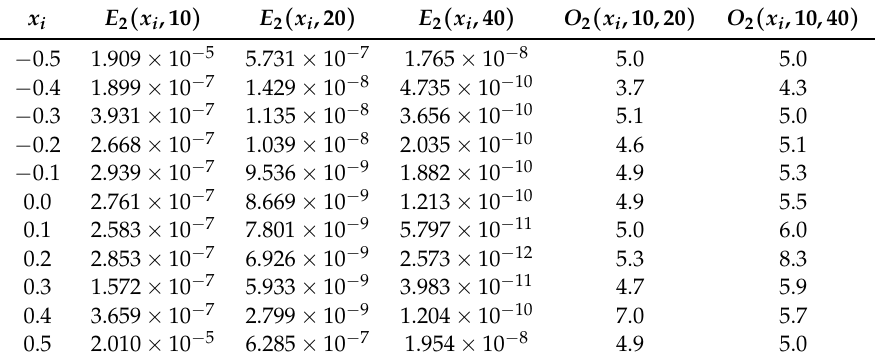
Table 10. The absolute errors of the second order derivatives of y 2 at the knots and the numerical convergence orders.